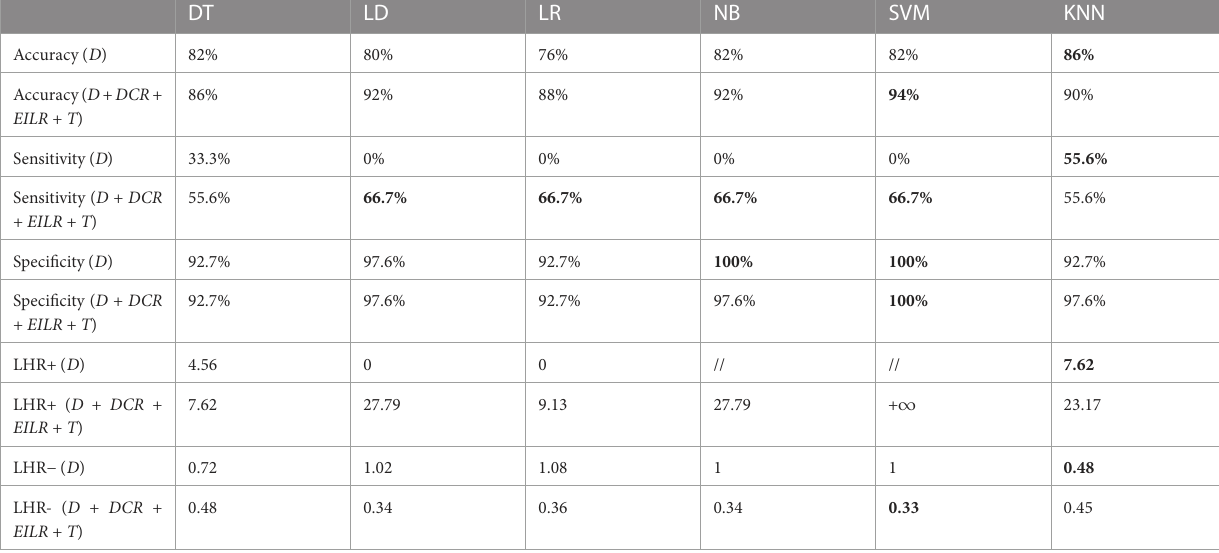
TABLE2 Classificationscoresforthesixclassifiersobtainedwithleave-one-outcross-validation:decisiontree(DT),lineardiscriminant(LD),logisticregression